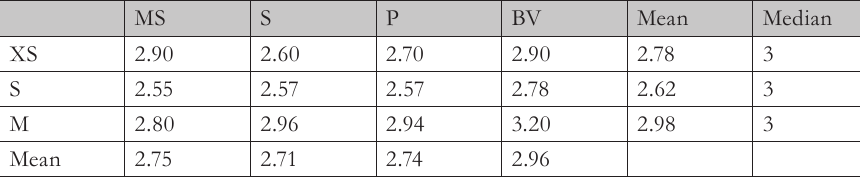
Tab. 5 – Business size sample of data according to the increase variable/mean values. Source: own research